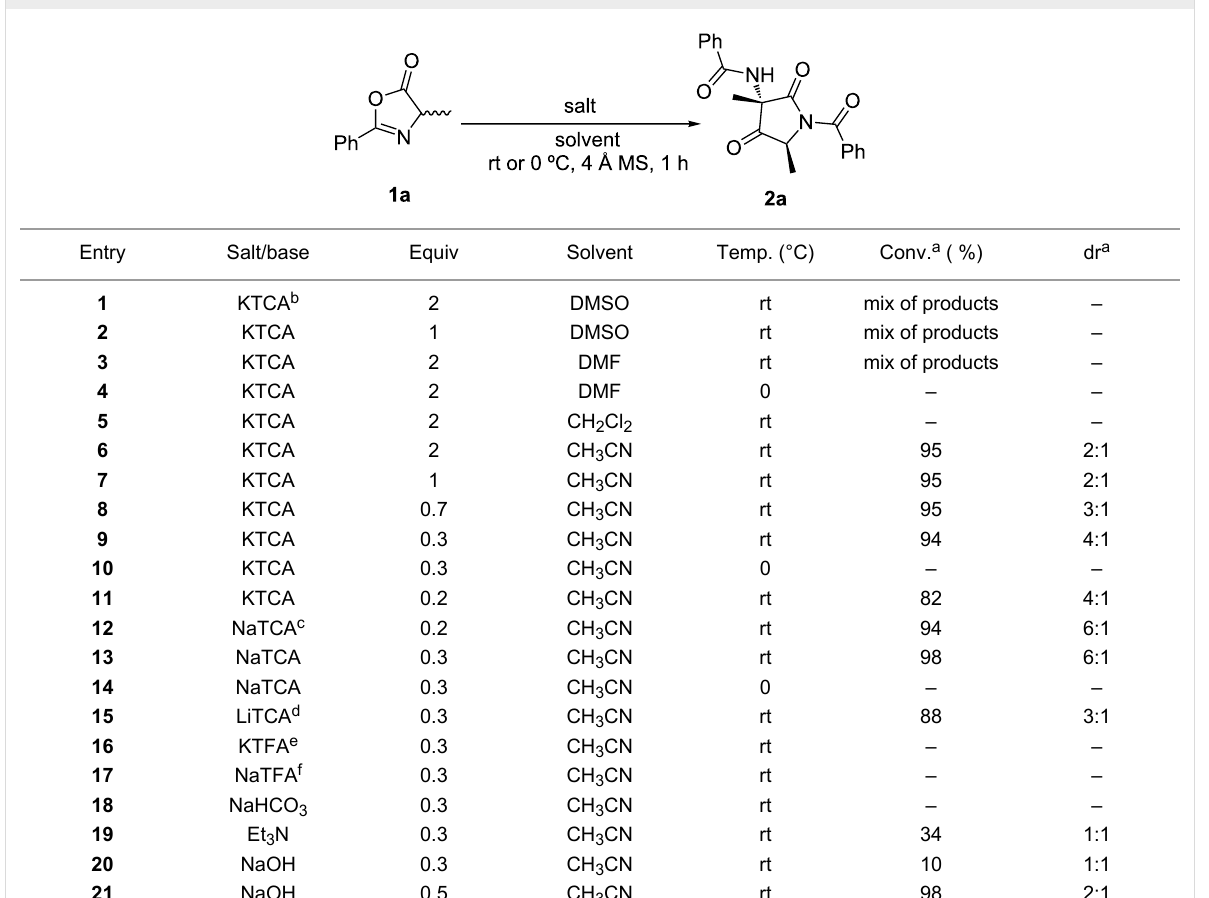
Table 1: Optimization reaction conditions of azlactones